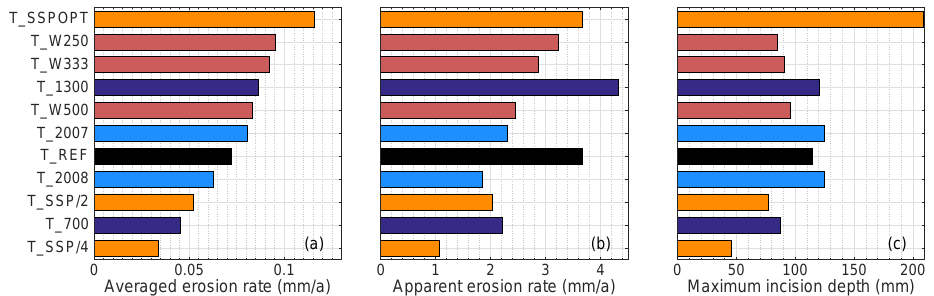
Figure 11. Synthesis of transient simulations (Table 4) through comparison of the following quantities calculated for one model year. (a) Erosion rate averaged over the whole glacier bed ( R R E tot d t d x ). (b) Apparent erosion rate calculated as the volume of sediment that is transported across the last grid node, i.e. terminus, ( R min( q s W ch ,Q tc )d t ) averaged over the glacier area. This quantity corresponds to what one would measure as the sediment flux in a proglacial stream. (c) Maximum incision depth (max (cid:0)R ˙ e tot d t (cid:1) ). Simulations are ranked by averaged erosion rate and the colours represent different simulation suites: black for “reference”, blue for “water input”, purple for “ice geometry”, red for “drainage width”, and orange for “sediment supply” (Table